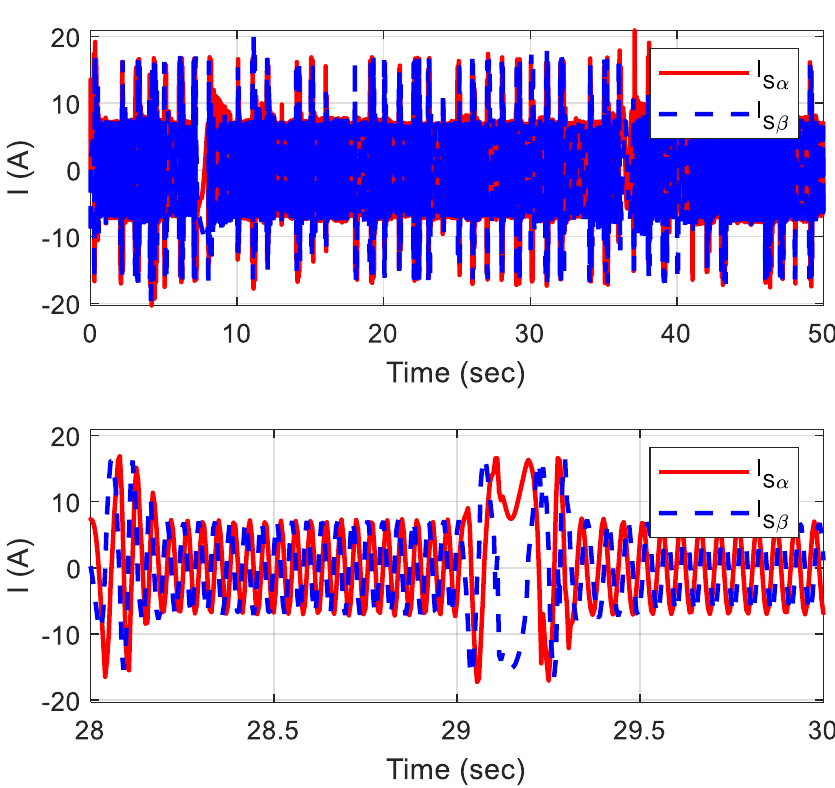
Figure 17. Dynamic performance of stator currents.